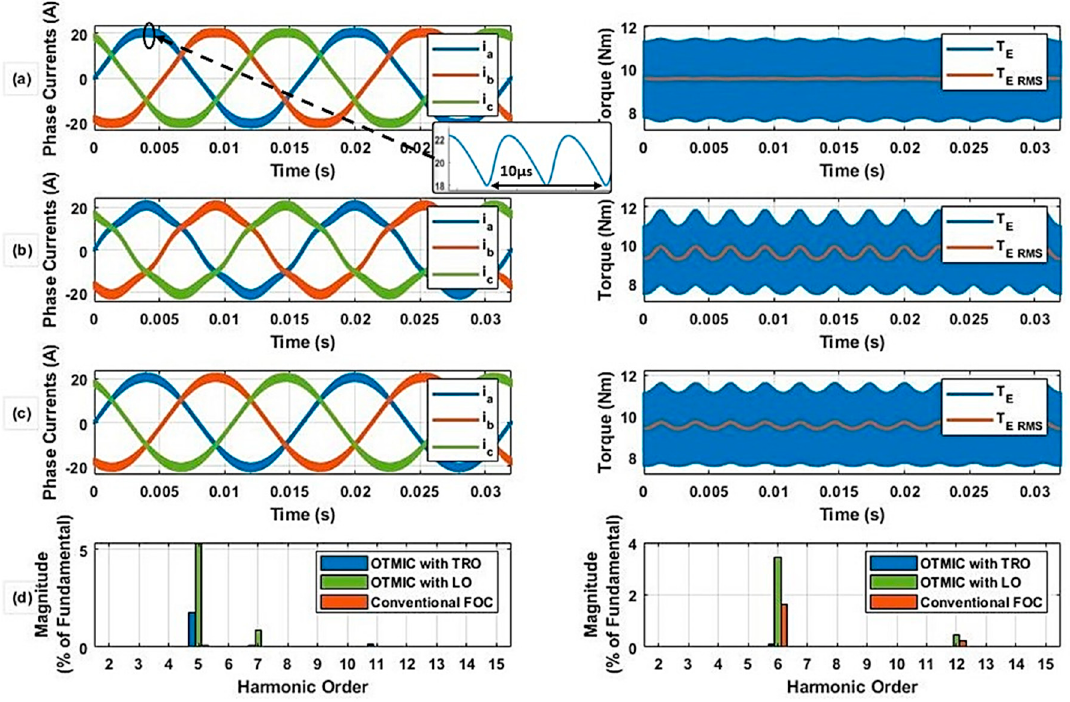
Figure 8. Simulation results of stator current and torque of: ( a ) OTMIC with torque ripples optimization, ( b ) OTMIC with losses optimization, ( c ) conventional DQ control and ( d ) harmonic spectrum of phase current (left) and torque (right) for every method [18].